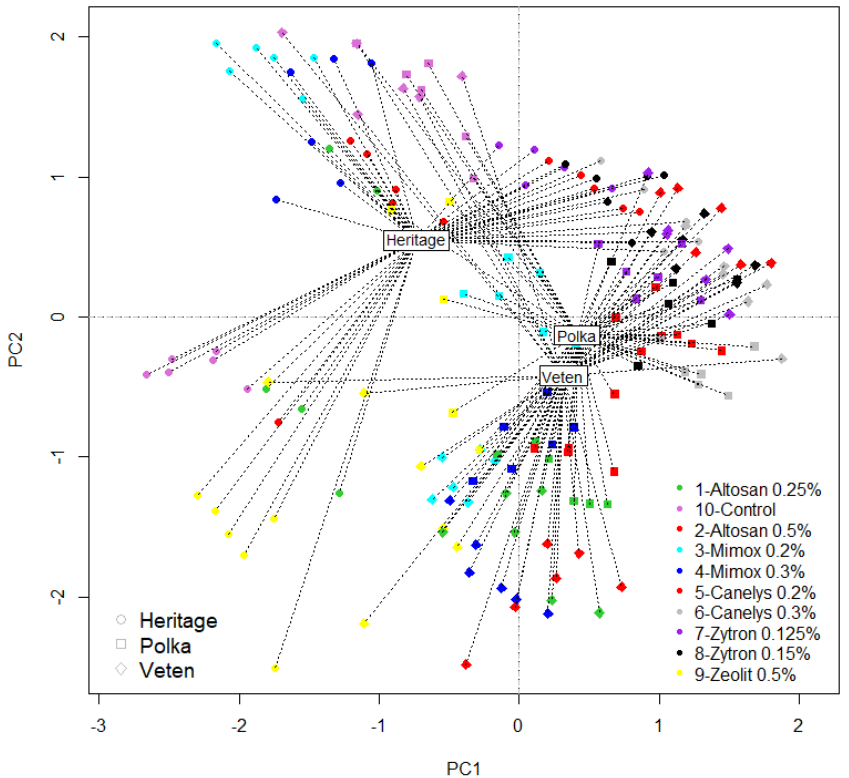
Figure 4. PCA raspberry rust disease treatment response. Variants tested: V1-Altosan 0.25%; V2- Altosan 0.5%; V3-Mimox 0.2%; V4-Mimox 0.3%; V5-Canelys 0.2%; V6-Canelys 0.3%; V7-Zytron 0.125%; V8-Zytron 0.15%; 9-Zeolite 0.5%; V10-Control. A full description of treatment recipes is provided in Table